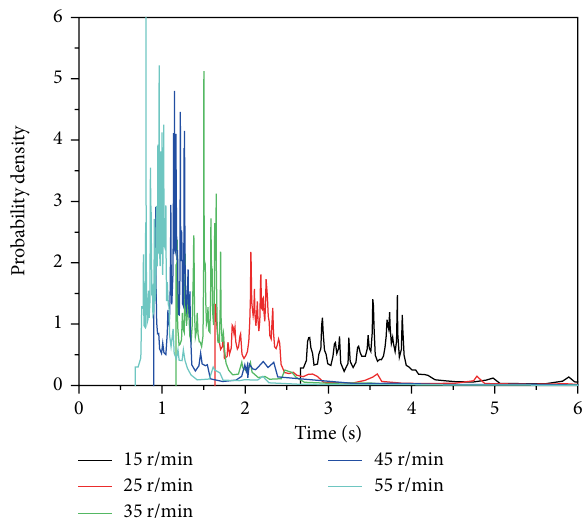
Figure 9: Influence of rotor rotational speed on residence time distribution.